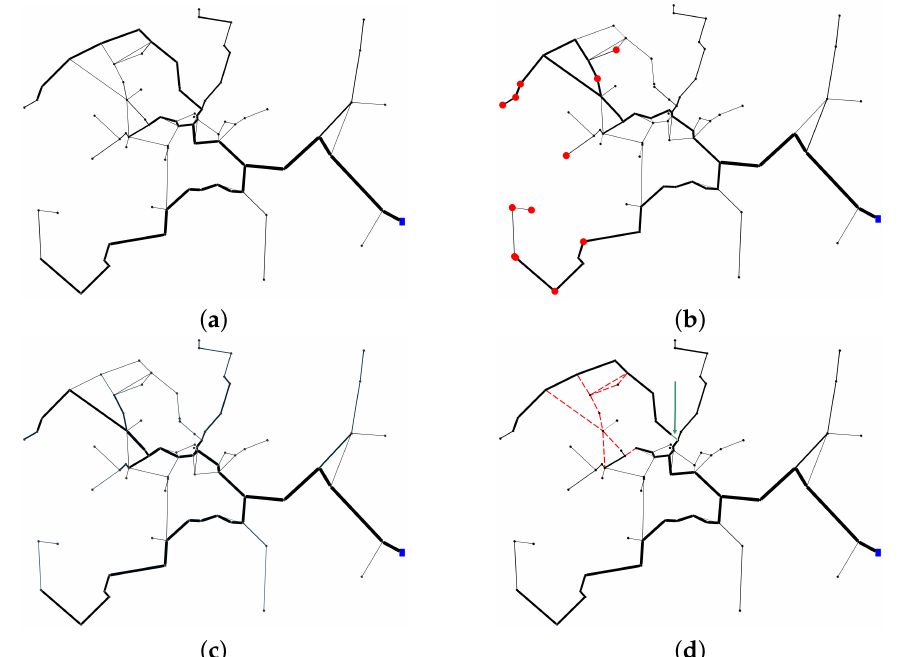
Figure 2. Network optimized with ( a ) multi-period simulation (total investment cost, TIC = 1.232 × 10 6 EUR ); ( b ) single-period optimization using maxPeriod (TIC = 0.967 × 10 6 EUR ); ( c ) single-period optimization using maxDemand (TIC = 1.270 × 10 6 EUR ); Network ( d ) shows that changing a single pipe causes velocity violations in other (non-neighboring)